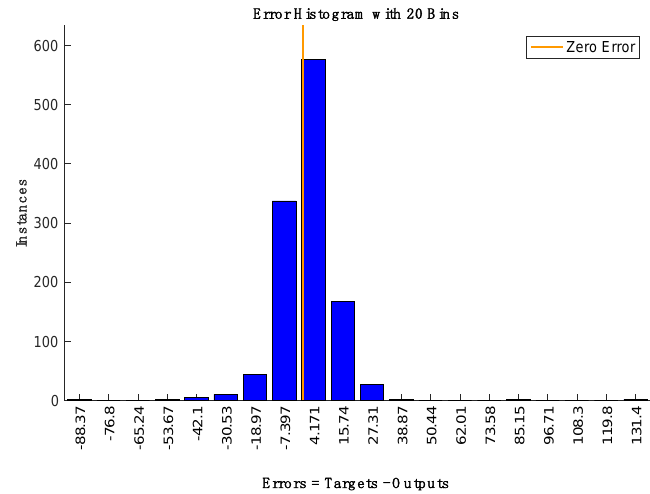
Figure 7. Estimated and measured total VOCs.